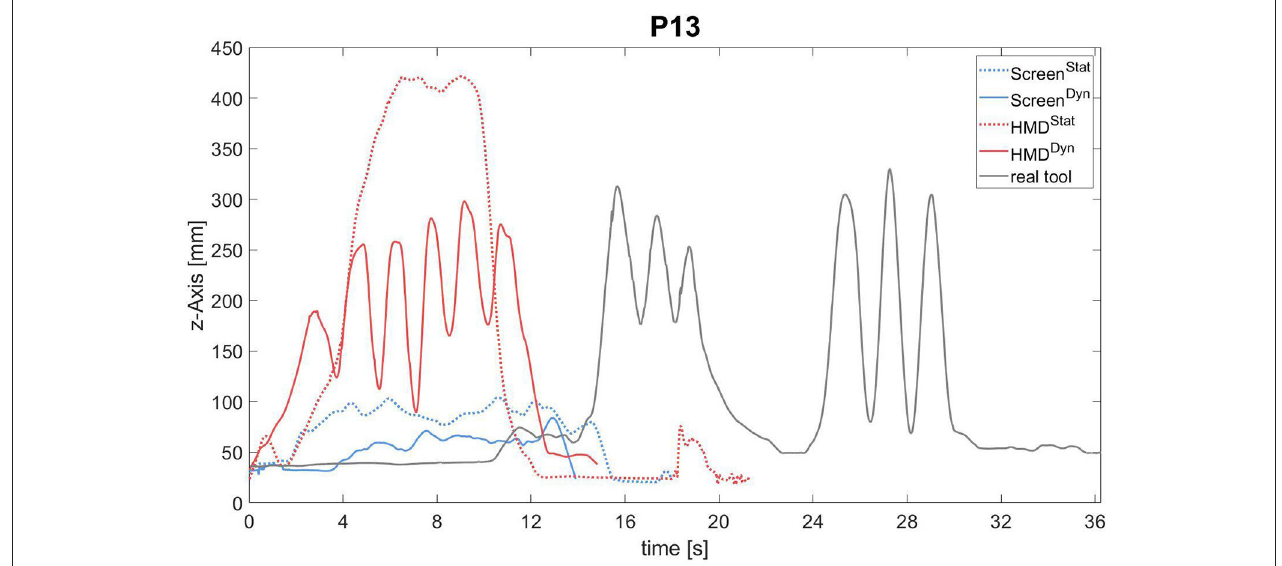
FIGURE 3 | Trajectories of hand movements in patient P13 attempting to pantomime the typical use of a hammer during the different experimental conditions is illustrated: Screen Stat (blue line), Screen Dyn (blue dotted line), HMD Stat (red line), HMD Dyn (red dotted line), real tool (gray line). The complete trajectory along the z-Axis in (mm) during the third of three trials is always shown.